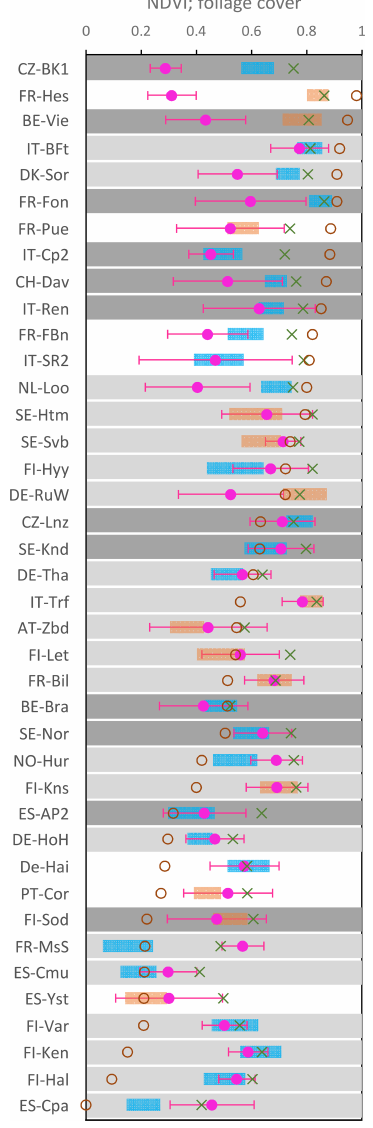
Figure 5. Estimated understory NDVI (NDVIu) ranges for se- lected days (see Sect. 2.3 for how the ranges are obtained; blue bars – site-representative retrievals; orange bars – possible non-site- representative retrievals), in situ measurements (mean ± 1 standard deviation (SD) shown in purple), and computed nadir total (un- derstory and overstory) NDVI values from MODIS BRDF/albedo data (green crosses). The fraction of foliage cover is shown with brown open circles. MODIS BRDF parameters with lower quality flags are indicated with light gray (QA = 1) or dark gray (QA > 1) bars. QA = 0 – best quality with full inversion; QA = 1 good quality with full inversion (including the cases with no clear-sky observa- tions over the day of interest and those with a solar zenith angle > 70 ◦ ); QA > 1 – lower quality magnitude inversion, using archety- pal BRDF shapes (for details please see Schaaf et al.,